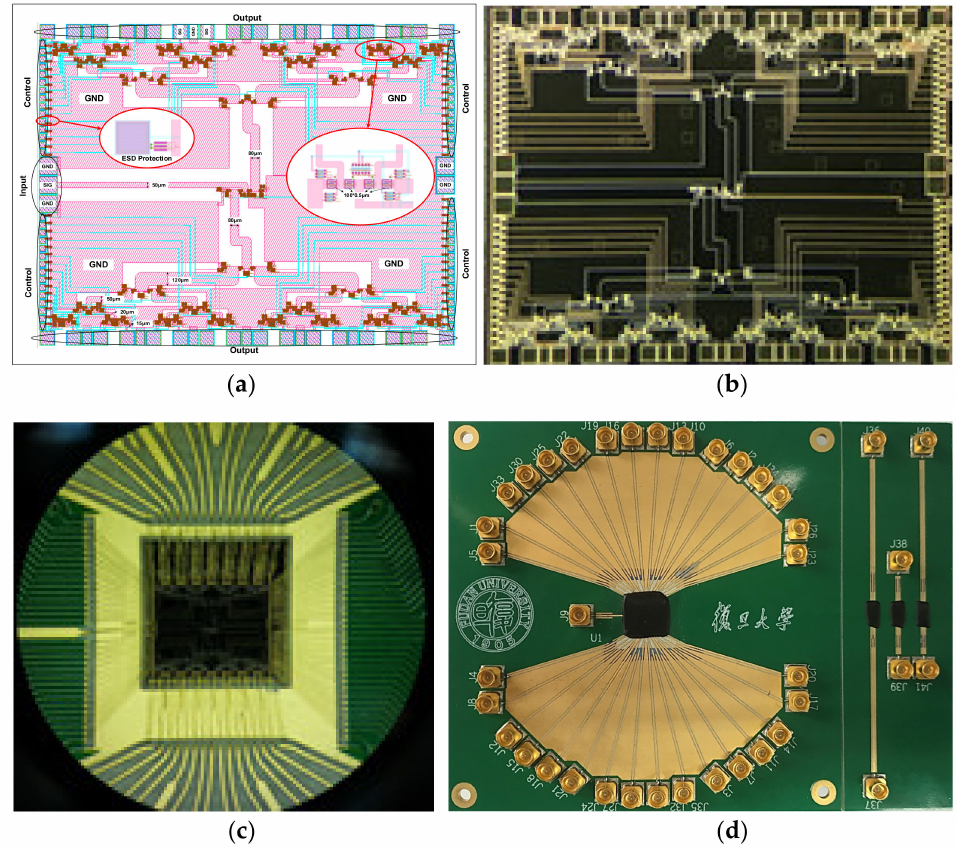
Figure 9. The details of the proposed single-chip switch: ( a ) layout; ( b ) chip photo; ( c ) bonding package; ( d ) chip on board